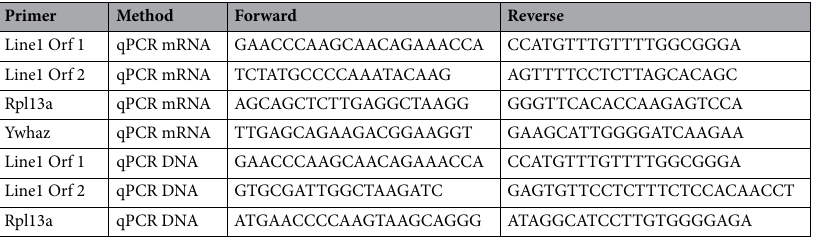
Table 1. mRNA and DNA primer sequences for